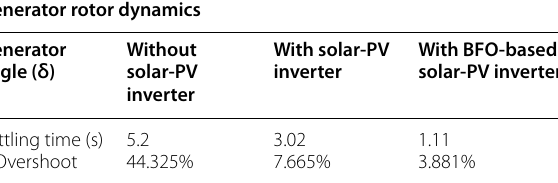
Table 5 Time domain specifications (Steady